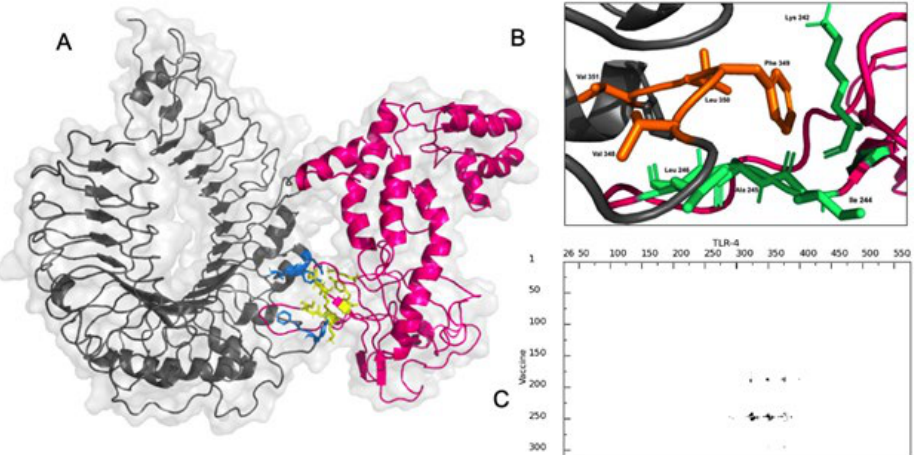
Fig. 7. (A) Interaction between Vaccine construct (pink) with binding region (blue) and TLR-4(grey) with binding region (yellow) (B) Hot regions of vaccine (green) and TLR-4 (orange) (C) interaction map between vaccine and TLR-4 by residue.